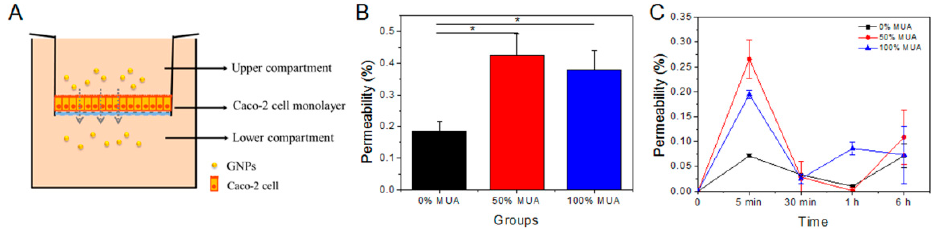
Figure 5. Permeability of GNPs with different surface charge distributions at various time points. ( A ) Schematic of GNP transportation in the transwell chamber from the upper to lower compartment. ( B ) Permeability of the three GNPs after 6 h. * p < 0.05. ( C ) Permeability of the three GNPs at 5 min, 30 min, 1 h, and 6 h.